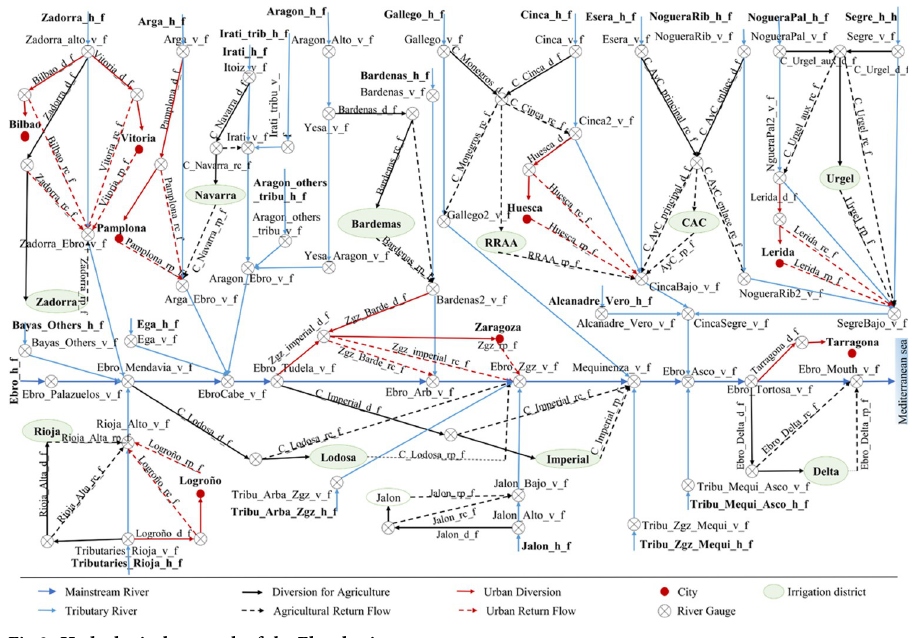
Fig 2. Hydrological network of the Ebro